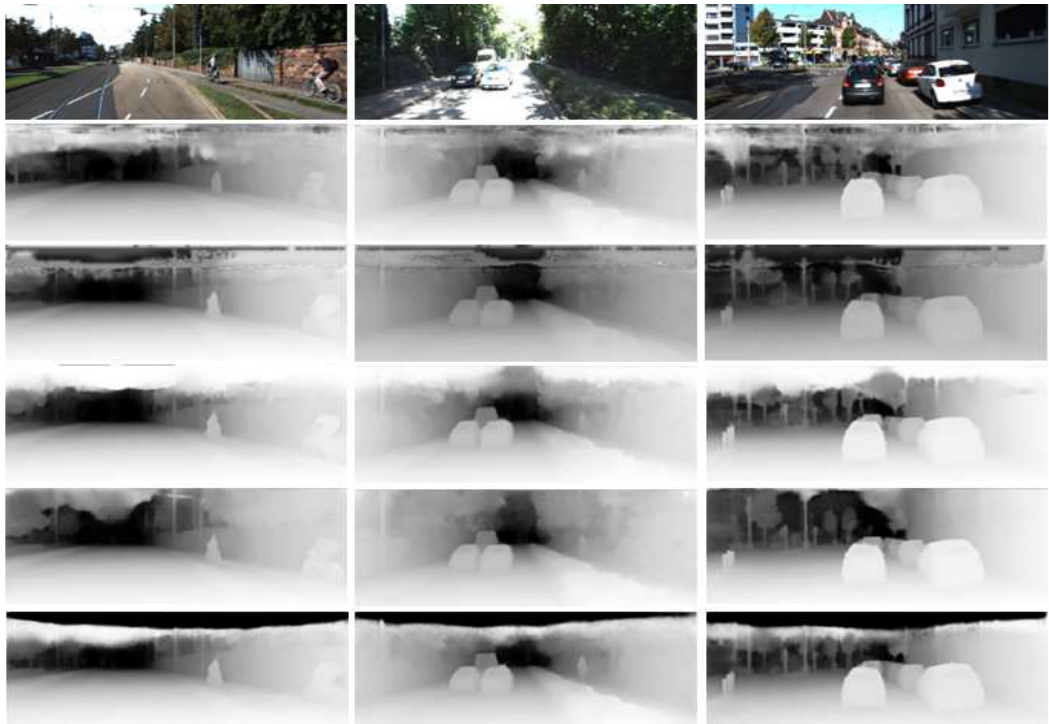
Figure 5. Result of predicted depth map on the KITTI Eigen split. From top to bottom: input image, BTS, Lapdepth, AdaBins, NeWCRFs, and ours.